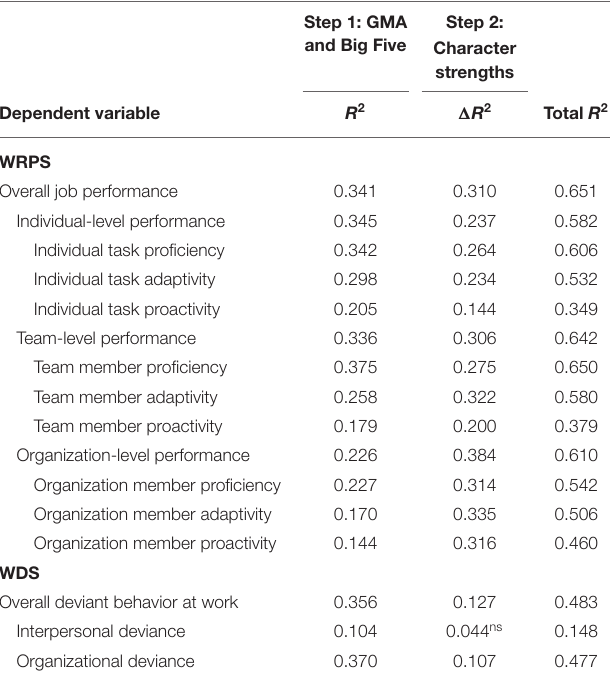
TABLE 7 | Hierarchical linear regression analyses: explained variance in dependent variables (Olkin–Pratt adjusted) by GMA and the Big Five (Step 1; method: Enter; CFT 20-R and MRS-25 scales) and character strengths (Step 2; method: Enter; VIA-IS120 scales with partial correlation coefficients ≥ 0.25 in accordance with Table 4